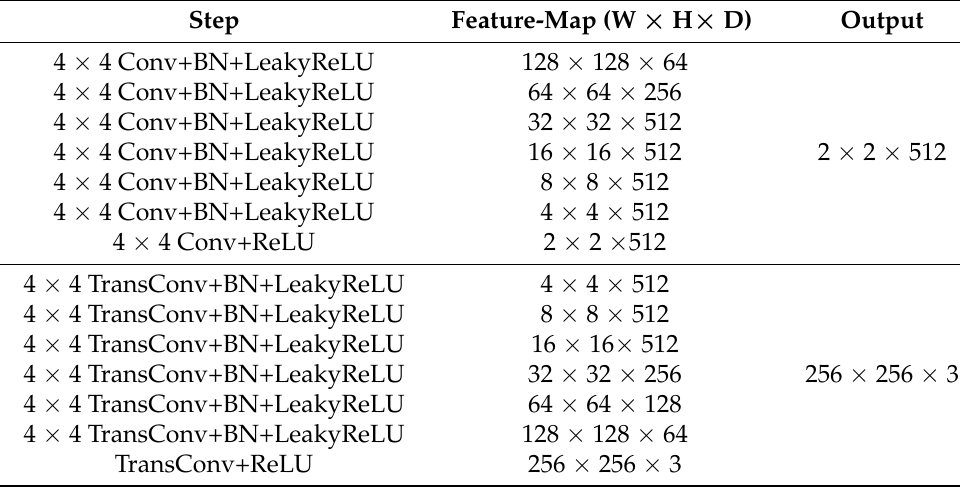
Table 1. Hiding Network Architecture.